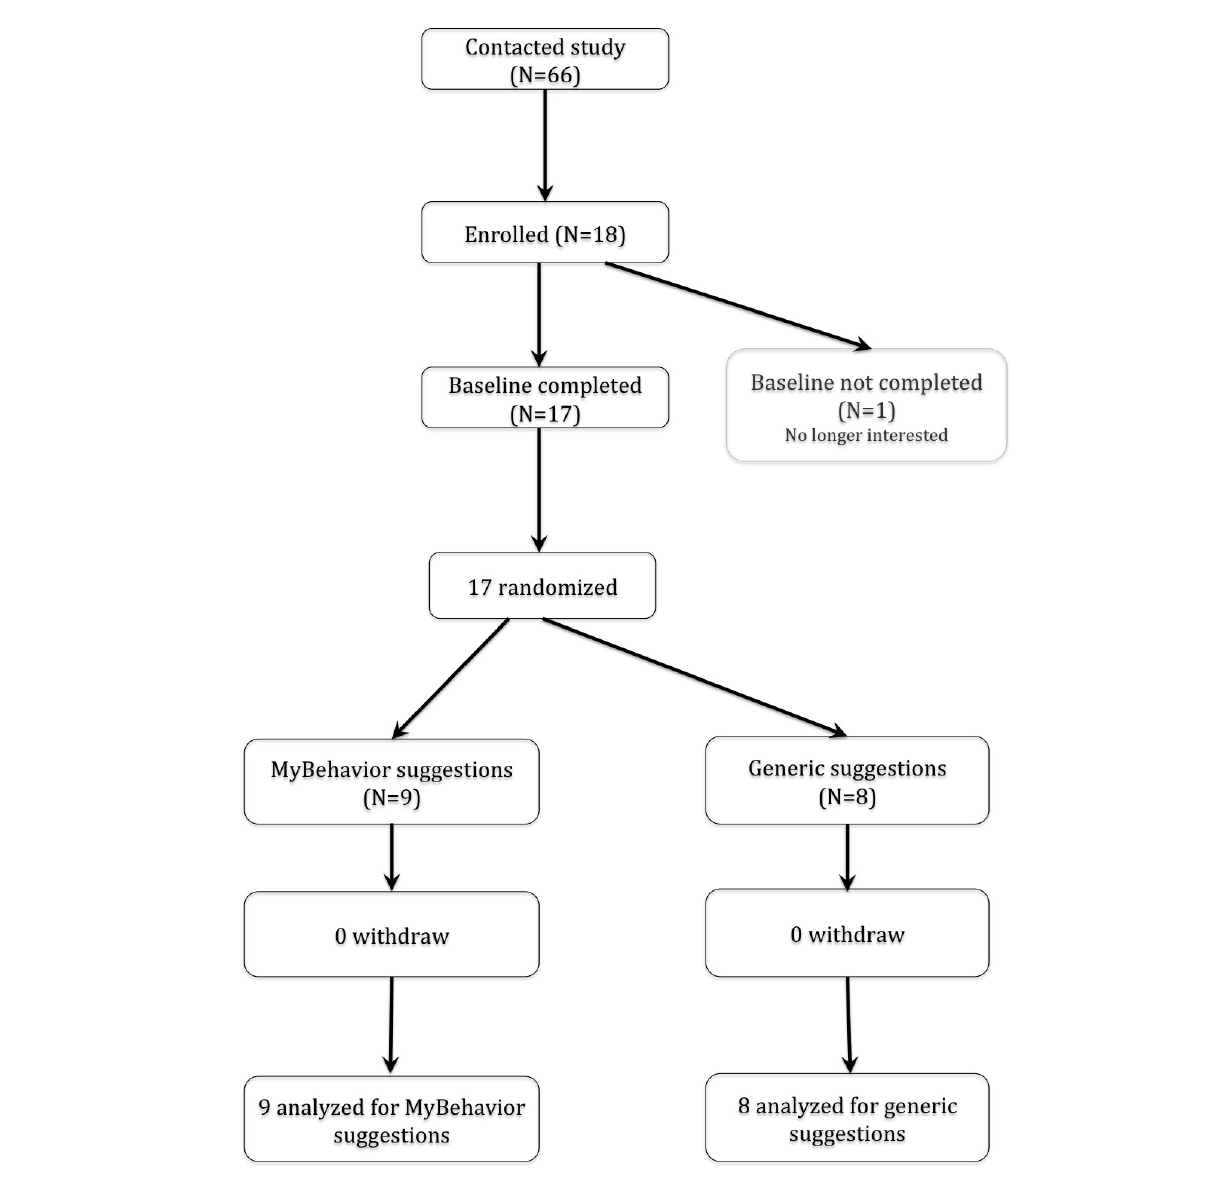
Figure 1. Flow of participants in the MyBehavior